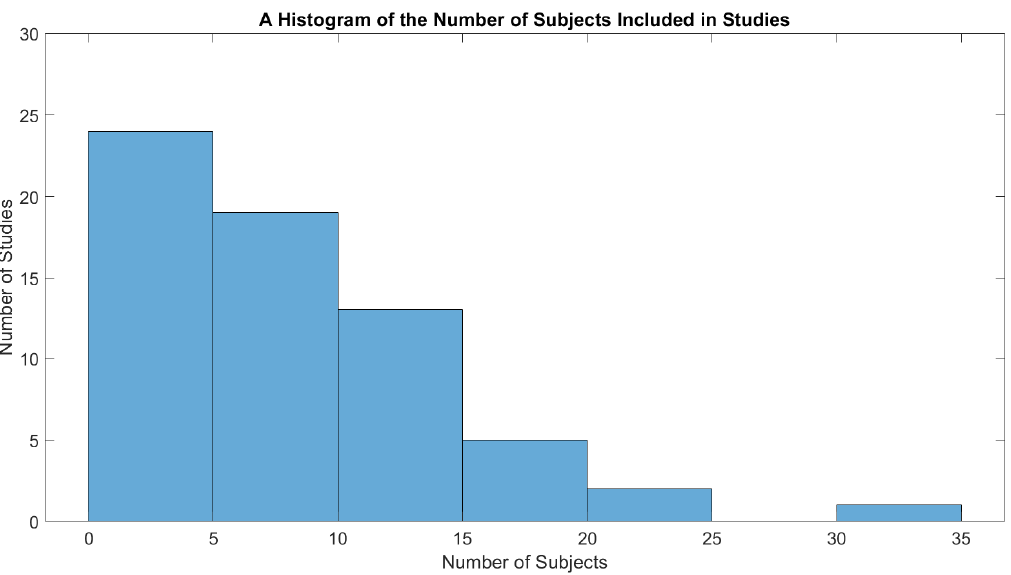
Figure 9. A histogram showing ranges of the number of subjects included in the studies reviewed. For each range, the right-hand number was included and the left-hand number was excluded.